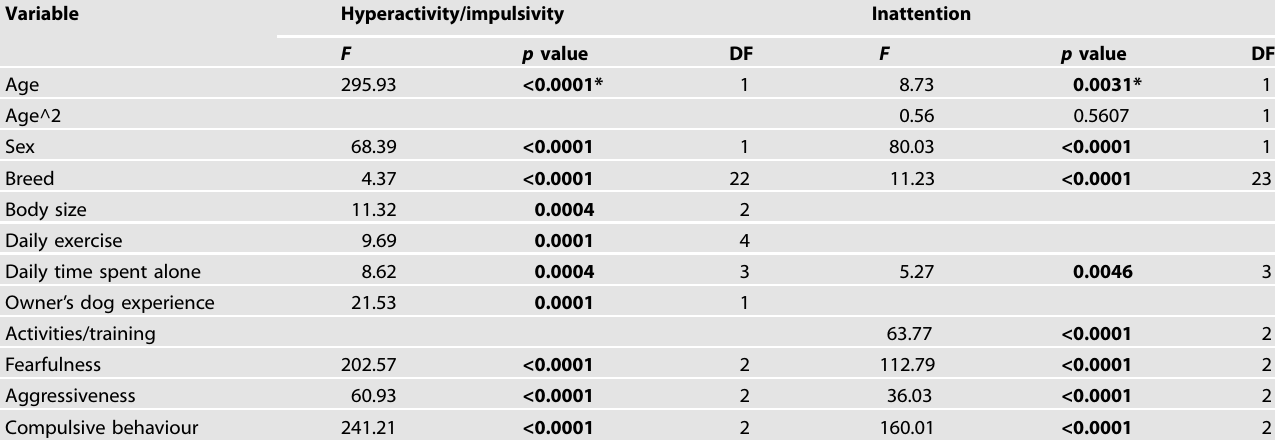
Table 1. Associations of the demographic, environmental and behavioural variables with hyperactivity/impulsivity and inattention scores in the generalised linear models with gamma distribution and log link